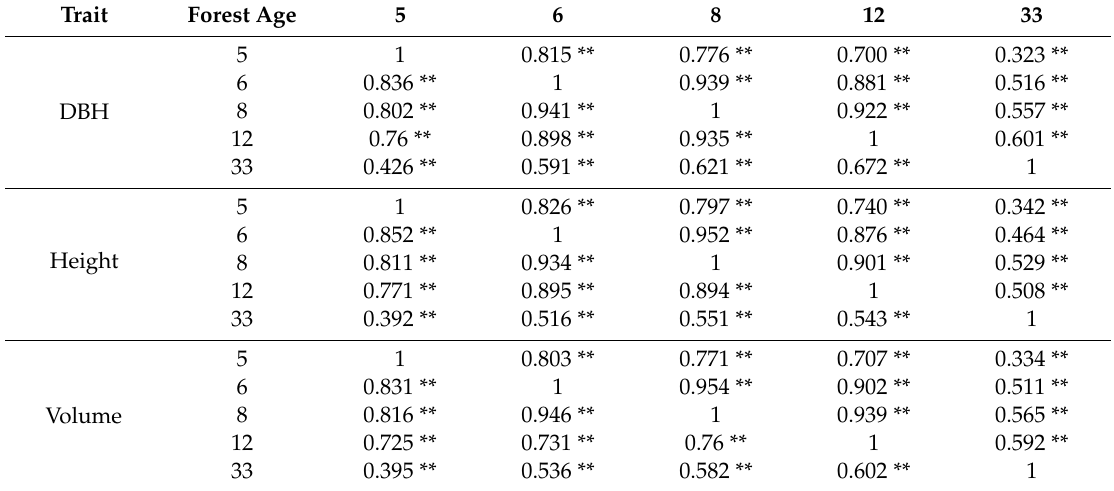
Table 5. Correlation coe ffi cients of the main tree growth traits for di ff erent forest ages. For each trait, data to the right of the “1” are phenotypic correlation coe ffi cients of the trait, and data to the left of the “1” aregenetic correlation coe ffi cientsof the trait. ** represents significant correlation at level < 0.01.